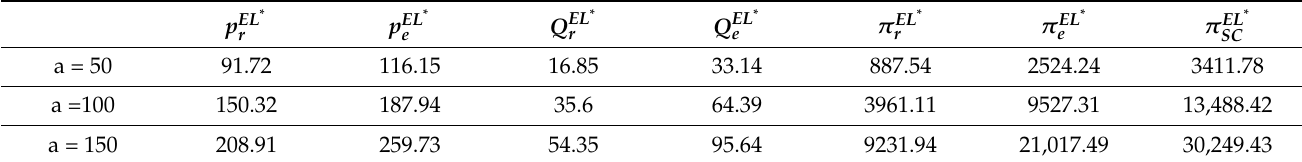
Table 6. Optimal decisions of channel members under EL game—Case 2.